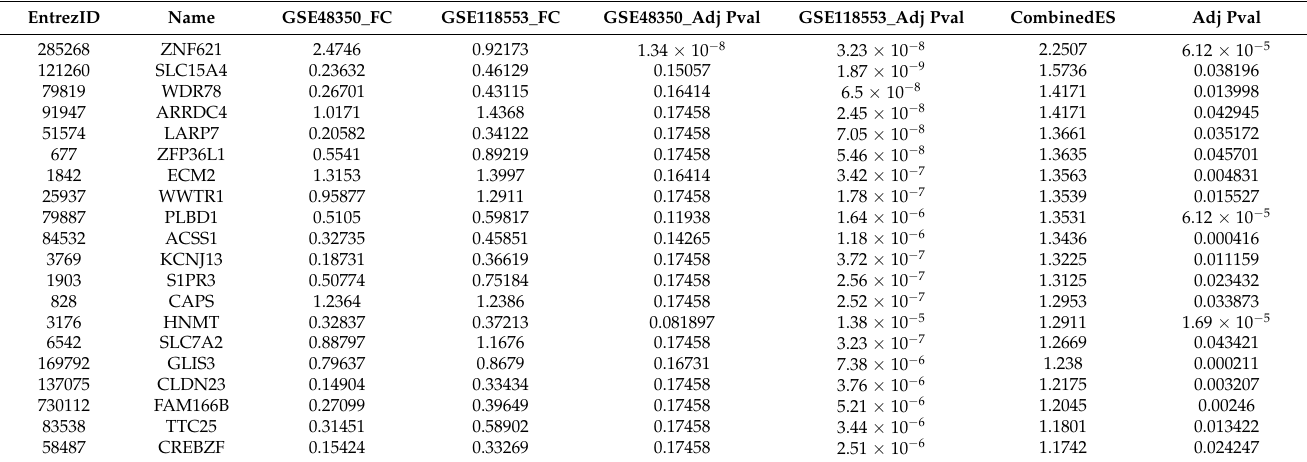
Figure 2. A meta-analysis of the GSE118554 and the GSE48350 data sets was performed for the identification of the differentially expressed genes (DEGs) characterizing the entorhinal cortex of AD patients and to perform a functional enrichment analysis. ( A ) Heatmap showing the most enriched terms among the upregulated and downregulated DEGs identified in the meta-analysis; ( B ) heatmap showing the putative transcription factors controlling the expression of the upregulated and downregulated DEGs identified in the meta-analysis. Table 1. Top 20 upregulated genes in AD entorhinal cortex.